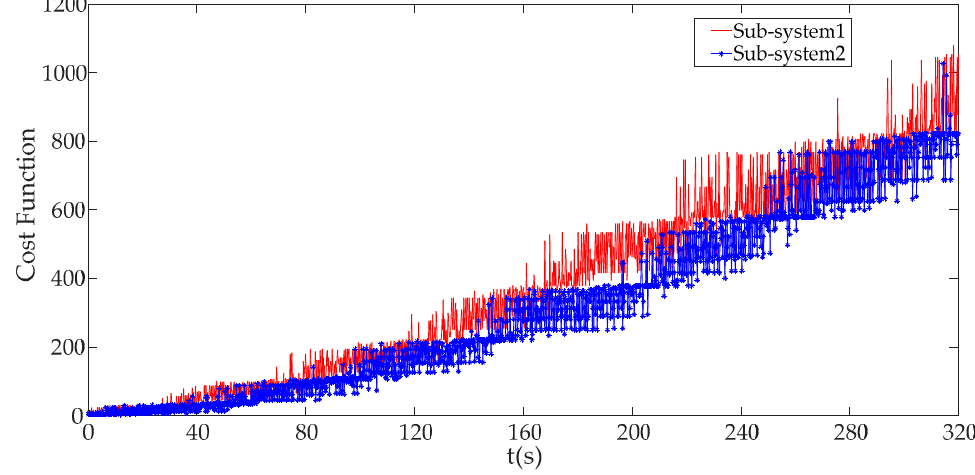
Figure 18. The cost function under DoS attack with an attack rate of 1,000.